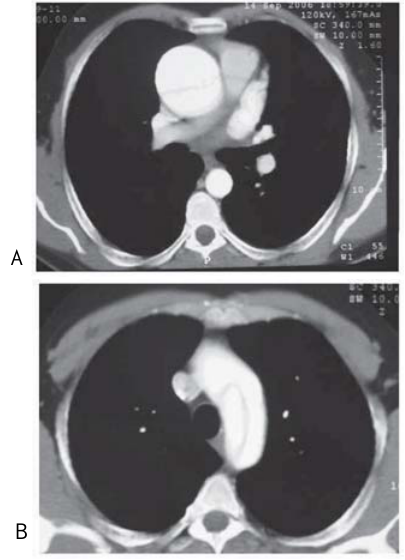
Fig. 1 - Angiotomografia de aorta ilustrando a delaminação do vaso, caracterizando a dissecção da aorta como tipo A de Stanford. A - Aorta ascendente dissecada com grande dilatação. B - Arco aórtico delaminado com diâmetro pouco